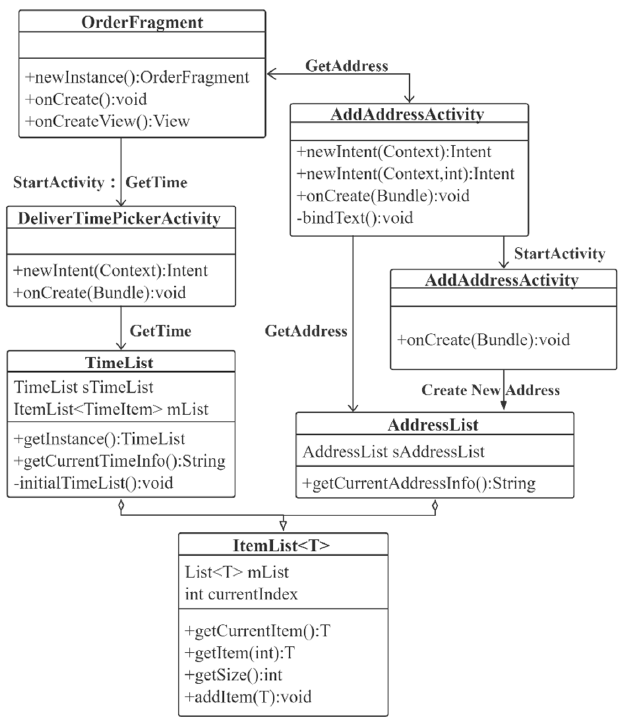
Figure 24. The interaction process between the order address and the delivery process.